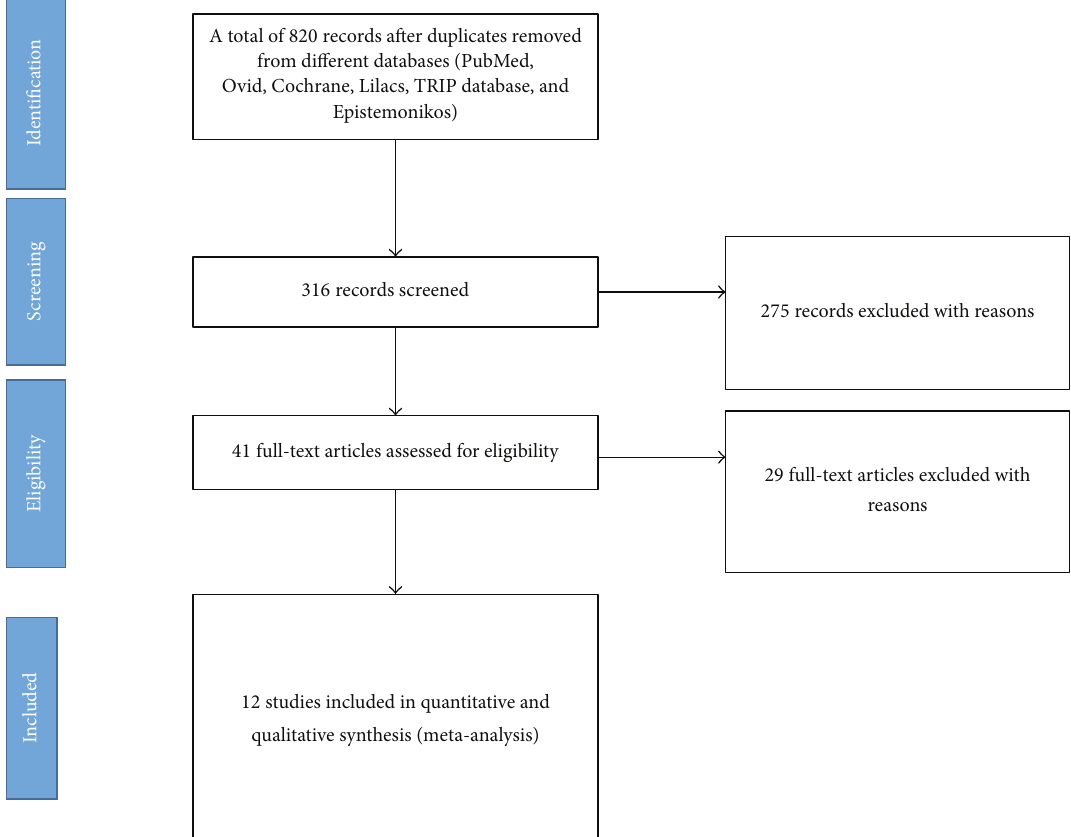
Figure 1: Study of flow diagram following PRISMA